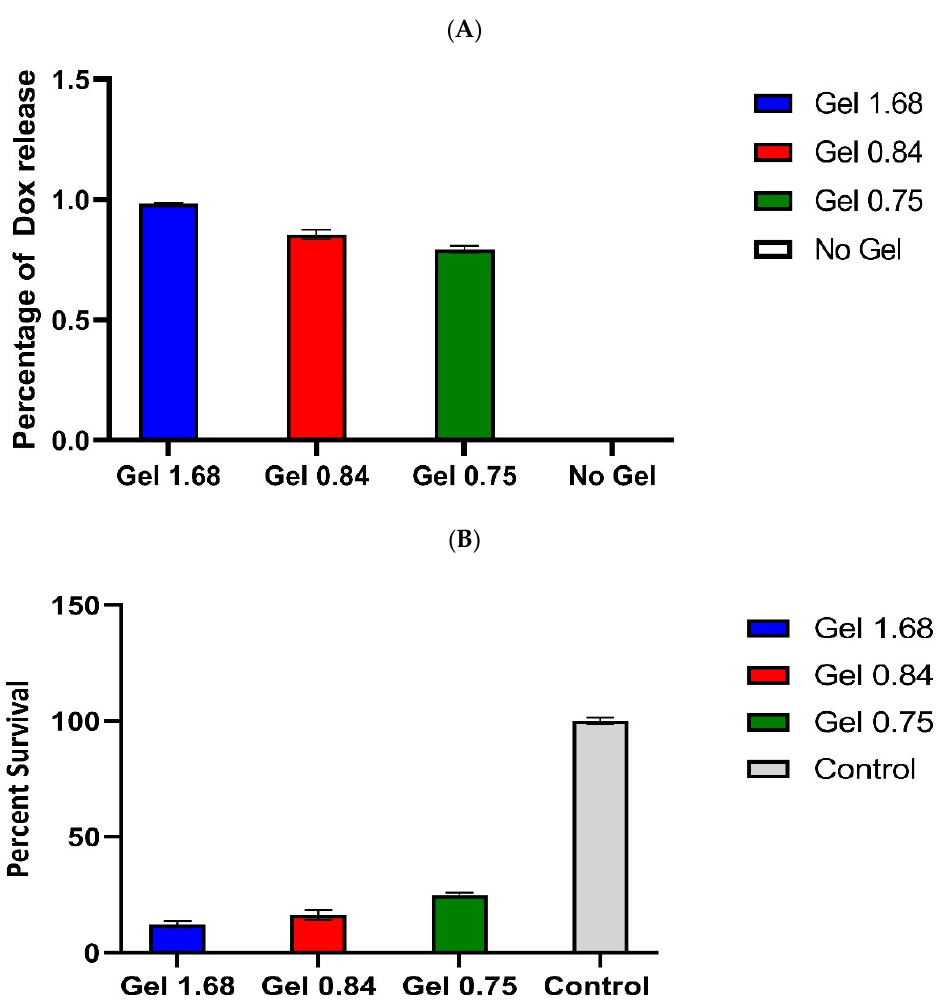
Figure 6. ( A ). Comparison of Dox release from different ELP based hydrogels. Doxorubicin concentra- tion in the media of hydrogel-treated wells was approximated based on the fluorescence property of Doxorubicin. Signal values were determined using a Synergy H4 plate reader, excitation 485nm and emission 590nm, and normalized to signal from untreated media. These values were compared to a plot of a Doxorubicin standard curve and are expressed here as approximate media concentrations of Doxorubicin ( µ M). Error bars represent S.E.M. ( B ). Cytotoxic effect of Dox delivered by ELP hydrogels in U-87 MG glioma cell line. U87-GFP-fLUC cells were incubated with hydrogel for 72 h. Cell survival was determined by MTT assay and is expressed here as a percentage of the signal from non-treated control wells. These values are averages from four independent experiments. Error bars are S.E.M.